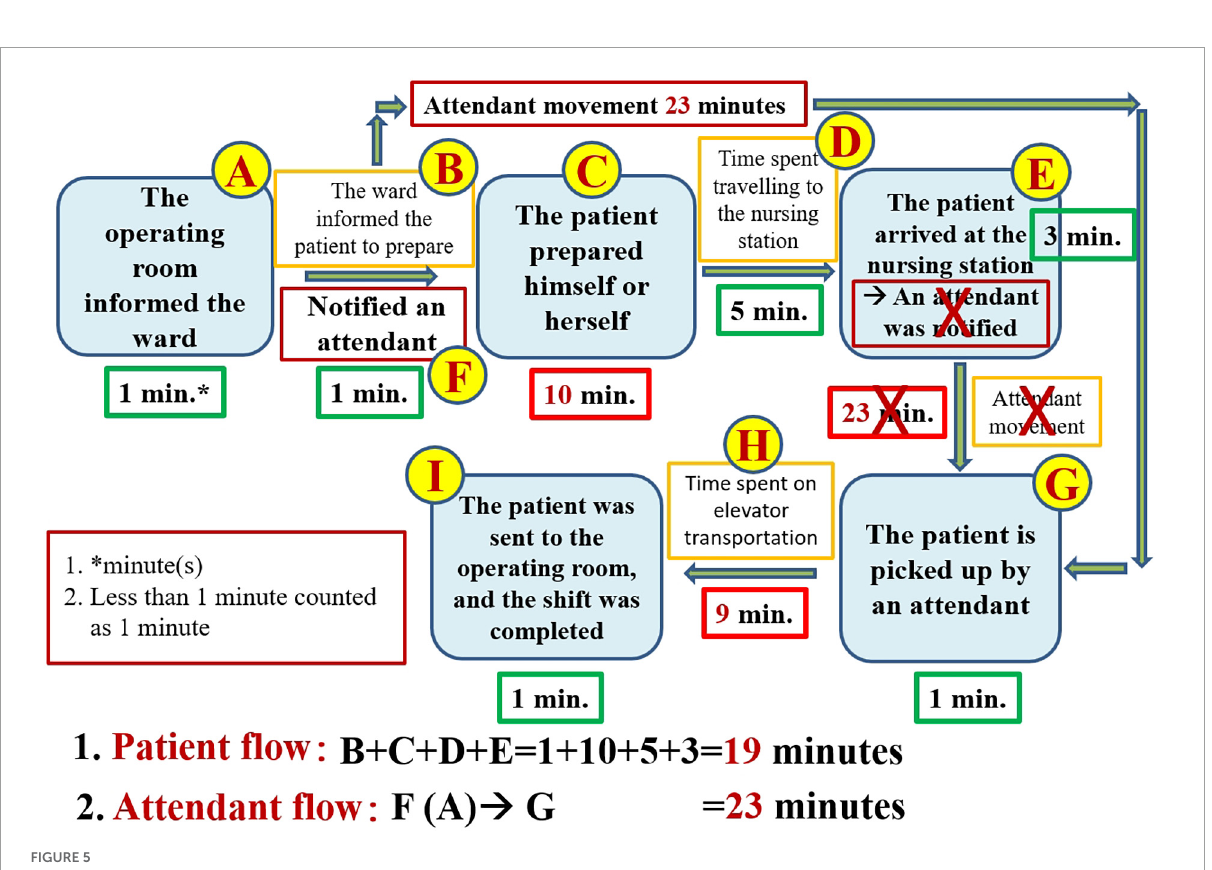
FIGURE5 Rearrange the step of notifying